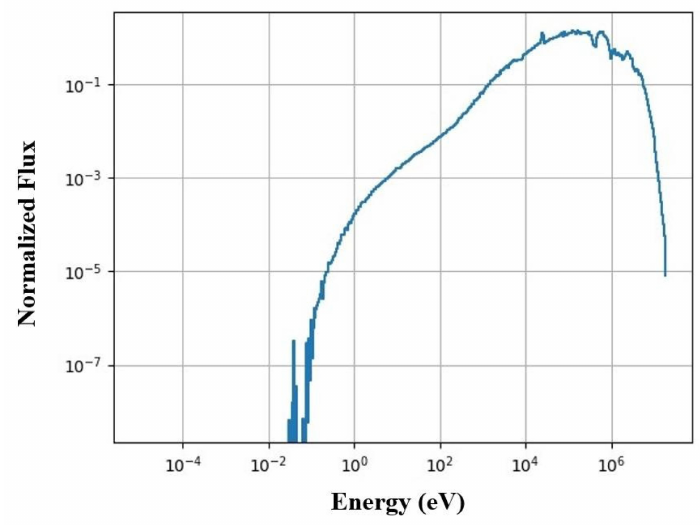
Figure 3. Energy spectra diagram of ADSR of fast spectrum (k eff = 0.97).